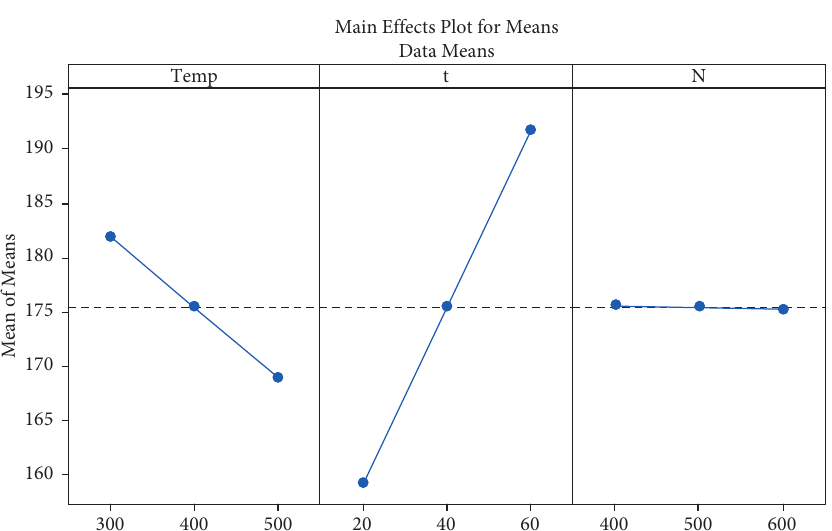
Figure 11: Significant consequence diagram based on means for porosity and compressive strength (temp: temperature in ° C; t : time in sec; N : stir speed in